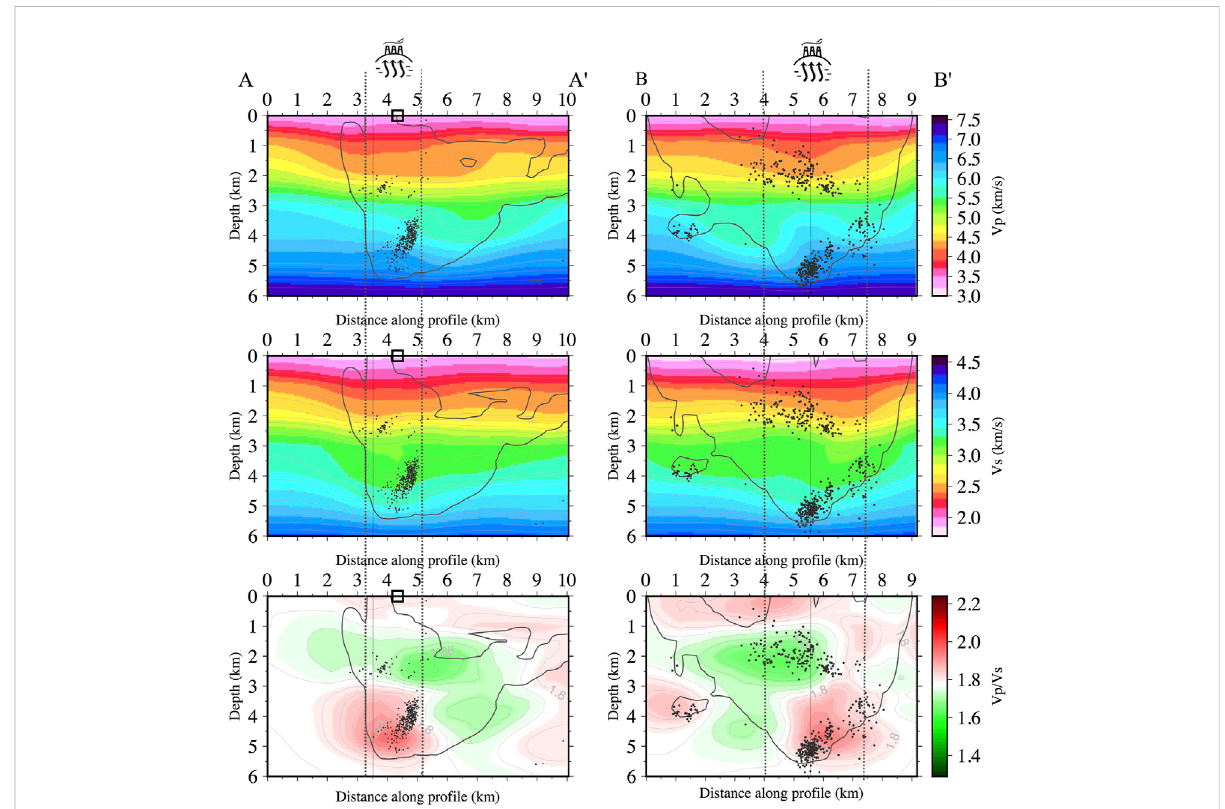
FIGURE 7 Tomographic cross-sections across (A) A ′ and along (B) B ′ the Nesjavellir valley. Pro fi le locations are given on Figure 1. Black dots represent earthquakes located within 250 m on each side from the vertical cross-section (A) A ′ (left panels) and within 500 m on each side from the vertical cross-section (B) B ′ (right panels). From top to bottom: P-wave velocity ( v P ) , S-wave velocity ( v S ) and v P v thewell-resolvedareainferredbytheDerivativeWeightSum(DWS).Theverticalblacklinerepresentstheintersectionofthetwocross-section. Nesjavellir power plant is marked with ablack square. The productionarea is indicated with two vertical dashed lines, the well trajectories are shown on Figure